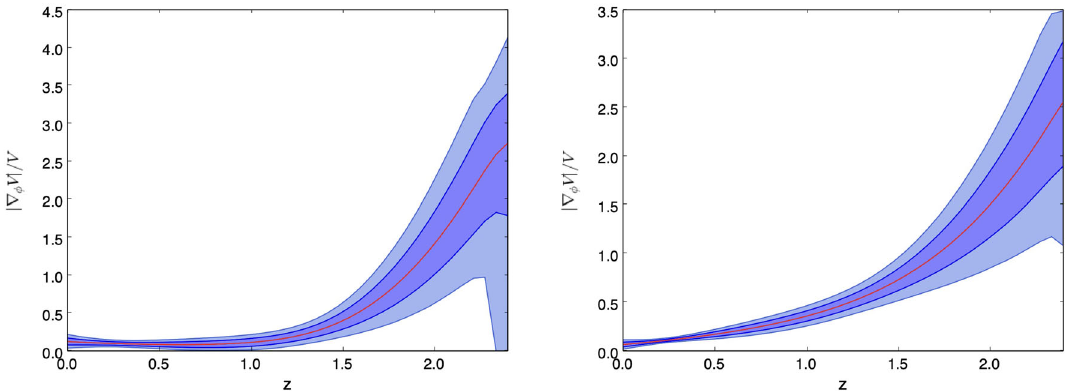
H 0 = 67 . 40 ± 0 . 5 km s − 1 Mpc − 1 has been merged to the expansion rate data used in the GP. The reconstruction thus obtained is for the f ( R ) model given by Eq. (22). The solid line depicts the mean of the reconstruction and the shaded blue regions the 68% and 95% C.L. of the reconstruction,